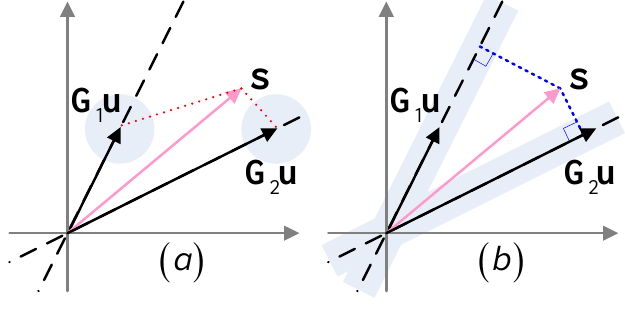
Figure 3. Multidimensional space for received signal under two target hypotheses. The situation without amplitude fluctuation is shown in (a) and the situation with amplitude fluctuation is shown in (b)